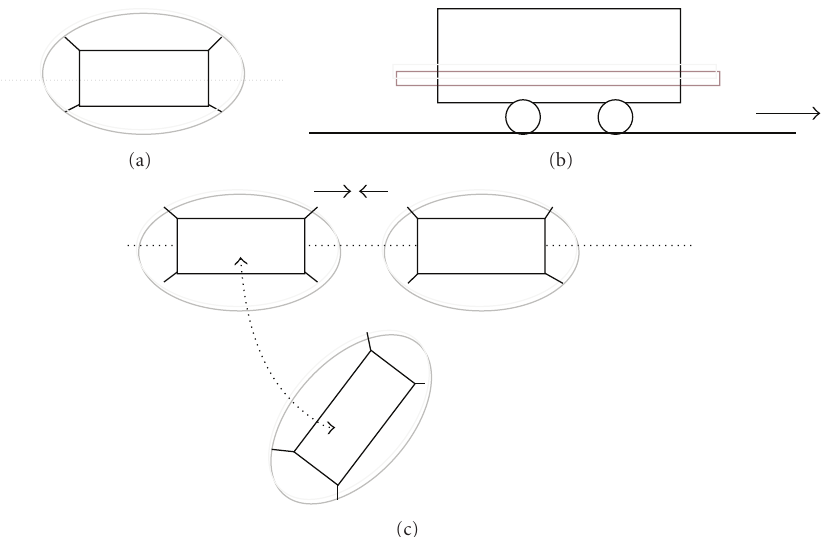
Figure 1: The shape ((a) is the above view and (b) is the front view) of an RAGV with tape holder around it. In (c) the turning process was shown in a collision